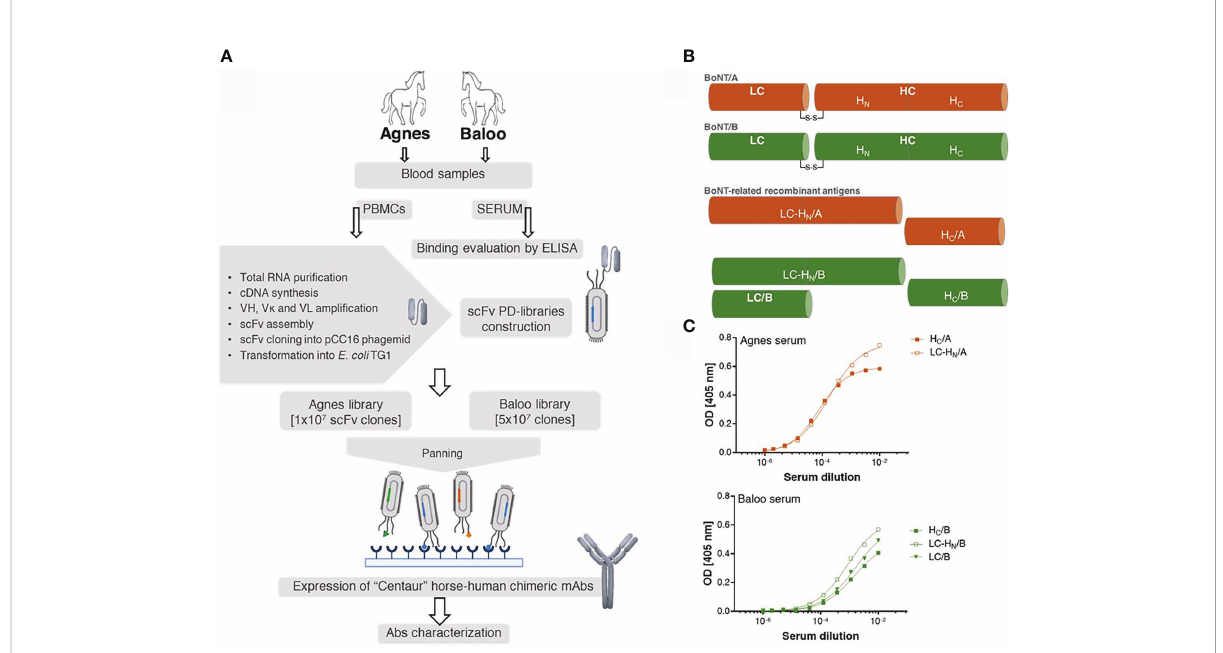
FIGURE 1 Study outline. (A) Schematic work fl ow of the development of horse-derived recombinant monoclonal antibodies (mAbs). Two horses, Agnes ( ♀ ) and Baloo ( ♂ ), immunized by administration of ( C ) botulinum inactivated neurotoxin (toxoid) serotype A or B (BoNT/A or BoNT/B, respectively) served as a source of PBMCs-cDNA. Two scFv-PD libraries were constructed based on Ab V-segments that were ampli fi ed using a newly designed primer set. Following enrichment by panning, speci fi c mAbs were isolated, cloned and expressed in CHO cells as recombinant horse- human chimeric Centaur mAbs. (B) Schematic representation of BoNT/A, BoNT/B and their related recombinant antigens. BoNT protein is composed of a 50 kDa light chain (LC), which encodes the effector molecule (responsible for the BoNT toxicity) connected by a disul fi de bridge to a 100 kDa heavy chain (HC). Receptor-mediated endocytosis followed by translocation of the light chain across the membrane into the neuronal cytosol is facilitated by the two HC functional domains, H C and H N , correspondingly. (C) Binding capacity of Agnes ’ s and Baloo ’ s sera, was evaluated by ELISA against indicated BoNT/A- and BoNT/B- recombinant antigens. Serially diluted serum samples were tested against the indicated